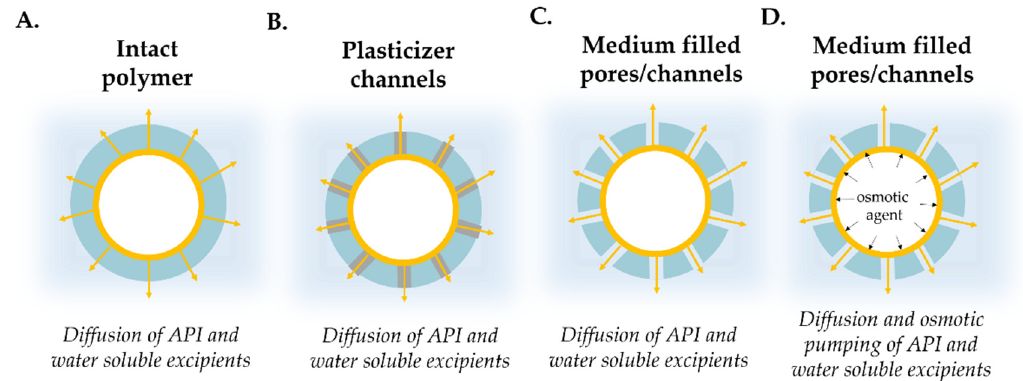
Figure 11. Schematic illustration of drug release mechanisms of coated pellets (( A ): intact polymer; ( B ): polymer coat with plasticizer channels; ( C ): coat with medium filled pores/channels; ( D ): osmotically active core)).